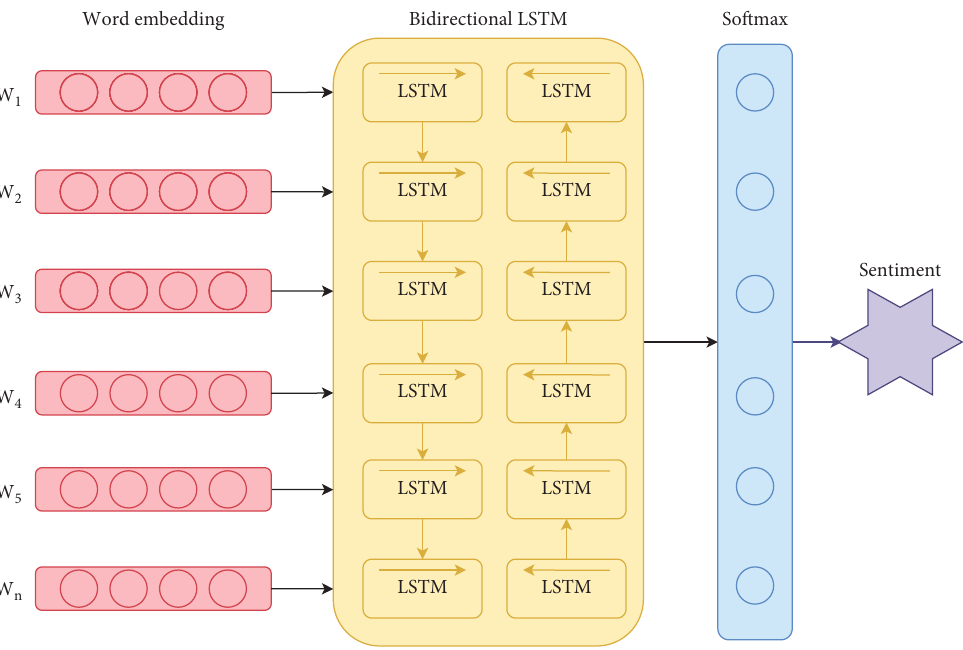
Figure 2: The architecture of the biLSTM